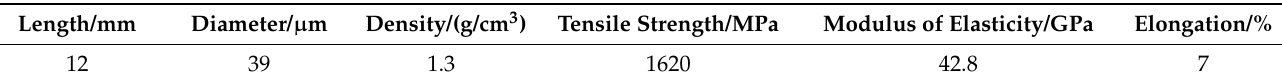
Table 2. Performance index of PVA fiber.